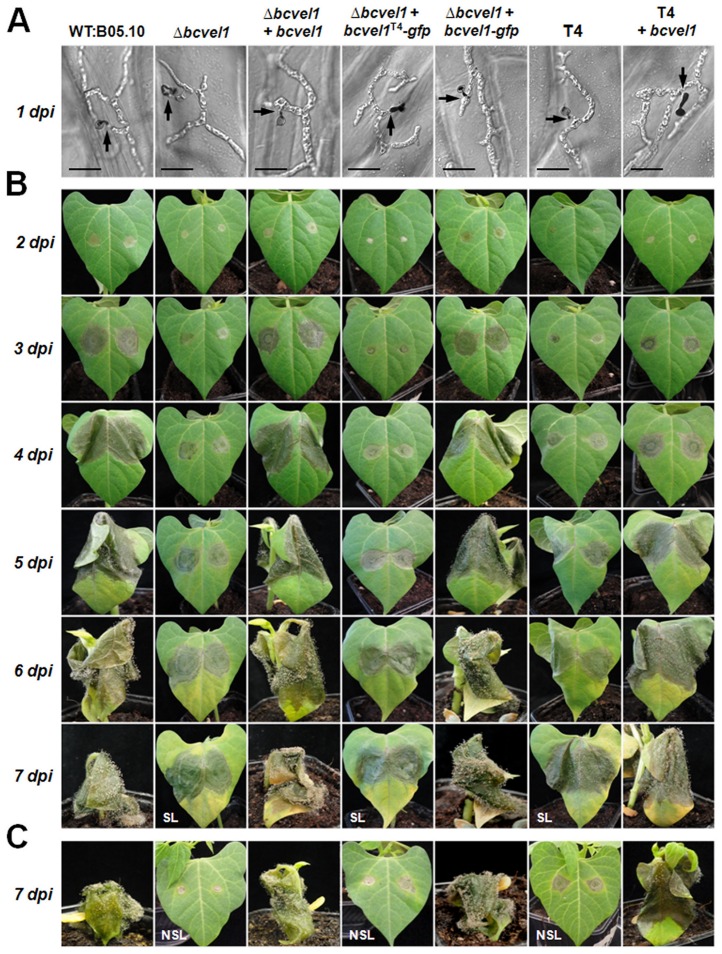
Virulence of strains carrying the different bcvel1 mutations.(A) Penetration of plant cells by germ tubes on onion epidermal strips (1 dpi). Conidia and hyphae on the surface were stained with lactophenol blue. Sites of penetration are indicated by black arrows. Scale bars represent 20 µm. (B) Complete infection cycle on primary leaves of P. vulgaris (2 to 7 dpi). Plants were incubated in humid conditions under natural illumination at room temperature. In this experiment, lesions of bcvel1 loss-of-function mutants were able to spread (SL, spreading lesions). (C) A further virulence assay on primary leaves of P. vulgaris (only 7 dpi). In this experiment, infection by bcvel1 loss-of-function mutants stopped in the primary stage (NSL, non-spreading lesions), while infection by the wild type B05.10 and complemented mutants was not affected.